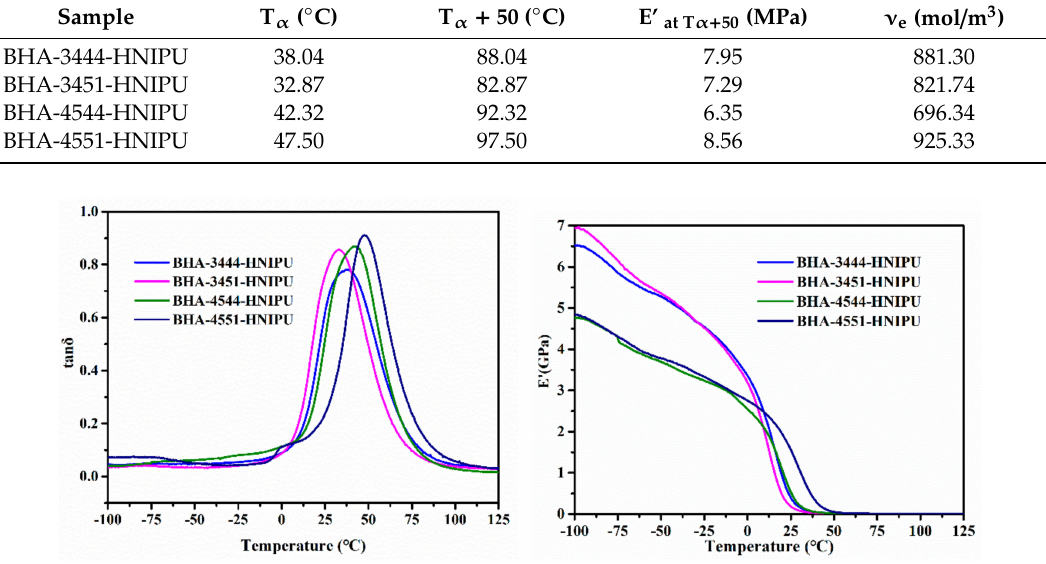
Figure 11. tan δ and E’ of